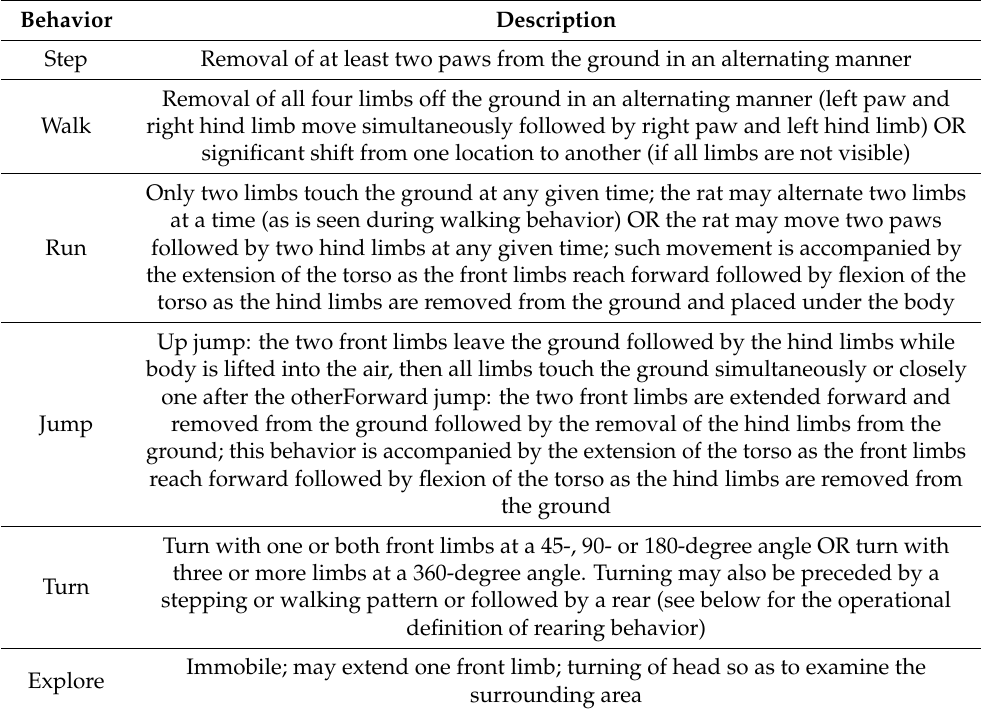
Table 1. Description of the anticipatory behaviors that were